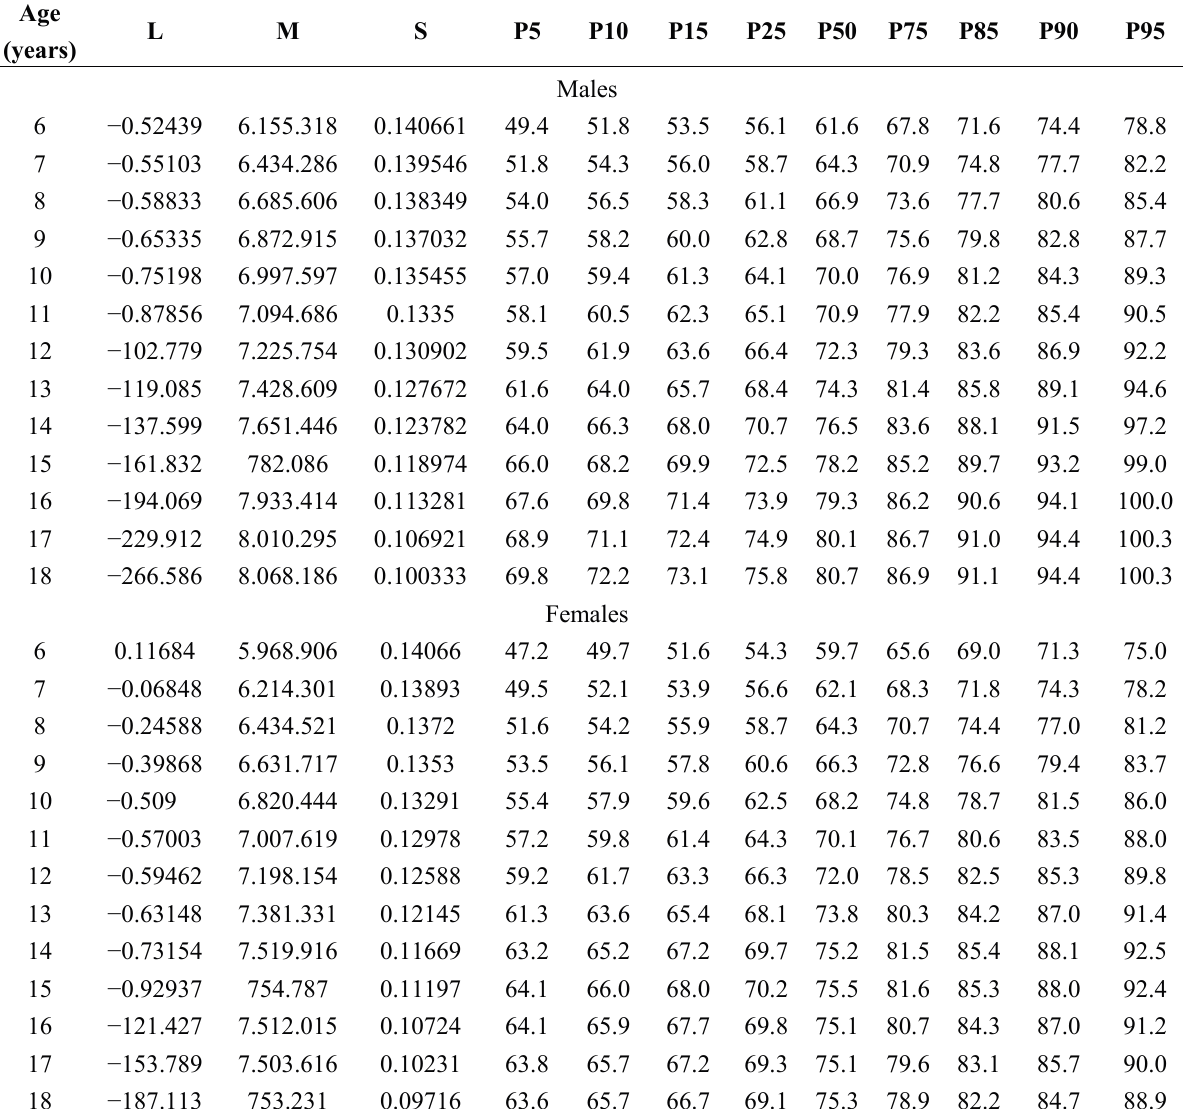
Table 2. Smoothed curve percentile distribution of waist circumference for children and adolescents of the Maule Region (Chile) based on age and